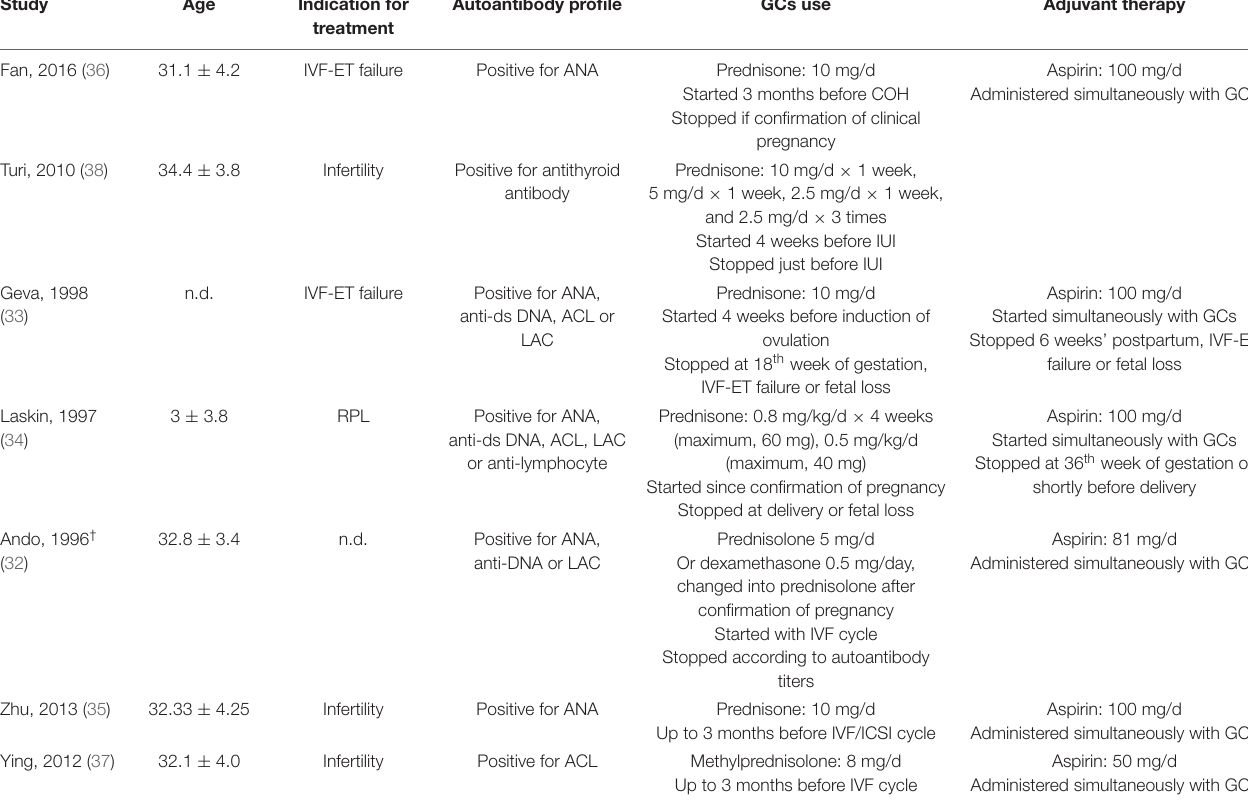
TABLE 1 | Characteristics of participants in the included